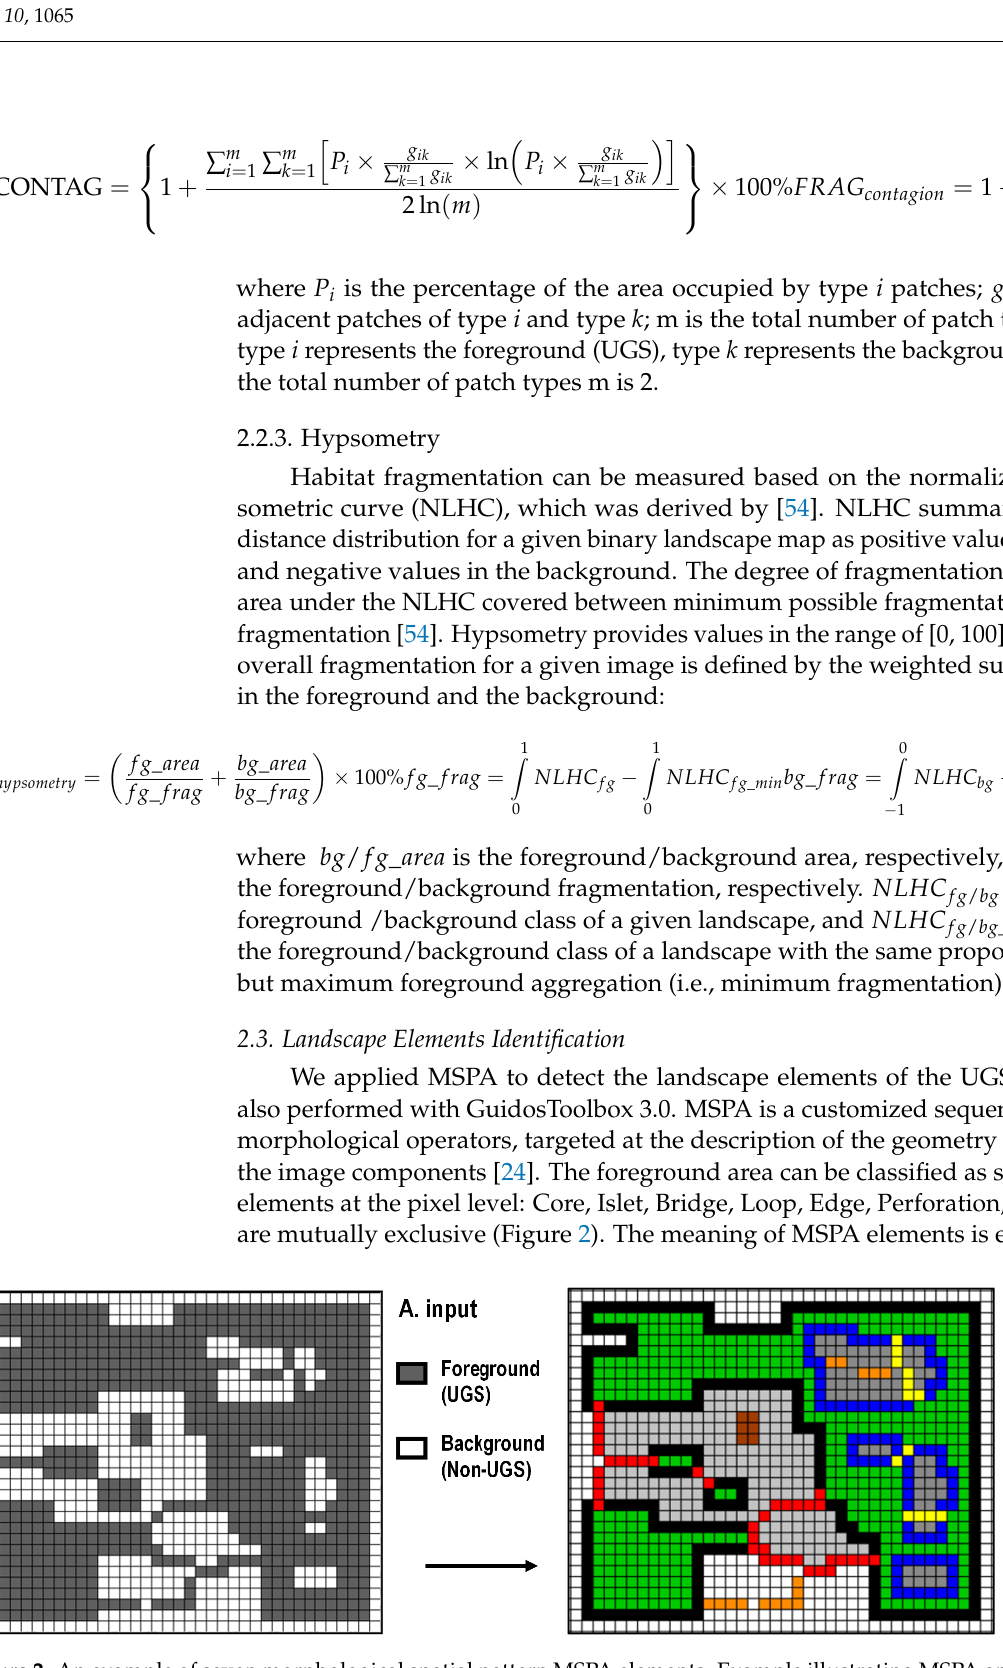
Figure 2. An example of seven morphological spatial pattern MSPA elements. Example illustrating MSPA analysis: ( A ) input binary map where the foreground corresponds to UGS and background to non-UGS; ( B ) output of MSPA analysis. This figure was depicted based on the following source: http://forest.jrc.ec.europa.eu/download/software/guidos/mspa/ (accessed on 12 May 2021). Table 1. Descriptions of the seven MSPA element types under mathematical and landscape ecolog- ical meaning.